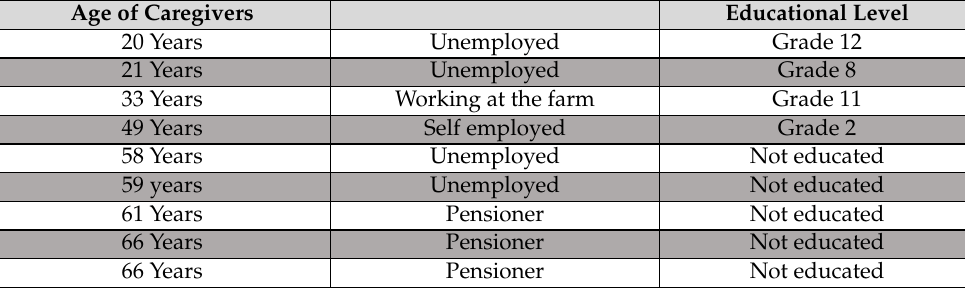
Table 2. Age, employment status and educational level of caregivers. Age of